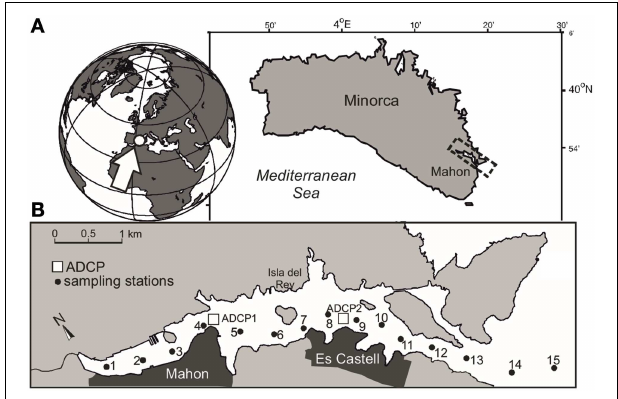
FIGURE 1 | (A) Map showing the location of Mahon in Minorca Island (Mediterranean Sea) and (B) the sampling stations (black dots) and location of the ADCPs (open